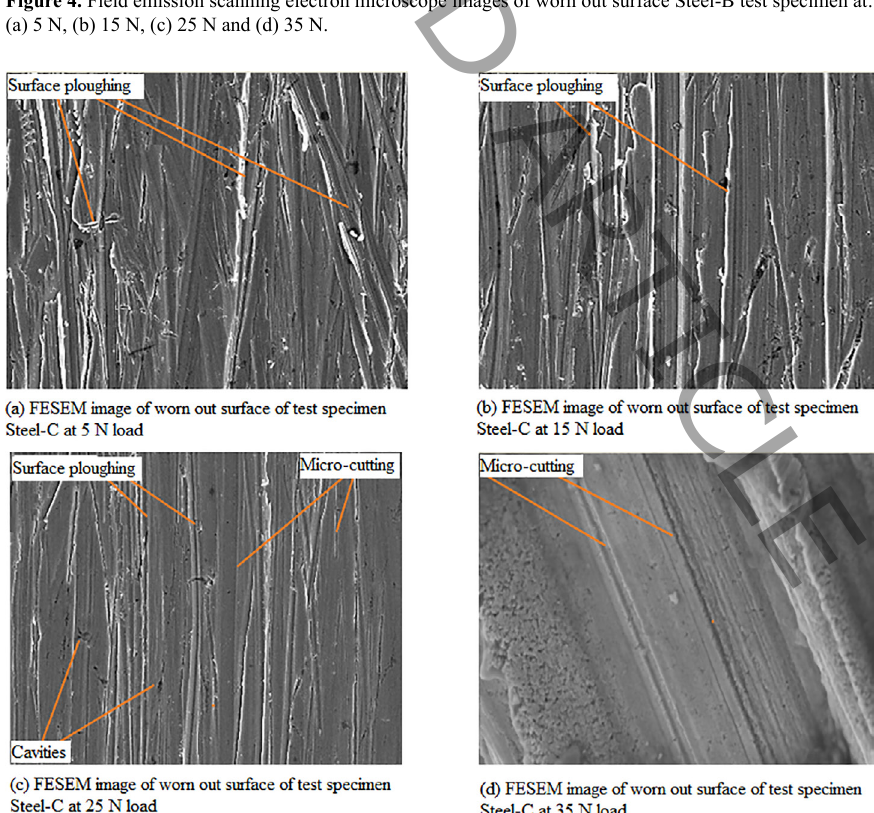
Figure 5. Field emission scanning electron microscope images of worn out surface Steel-C test specimen at: (a) 5 N, (b) 15 N, (c) 25 N and (d) 35